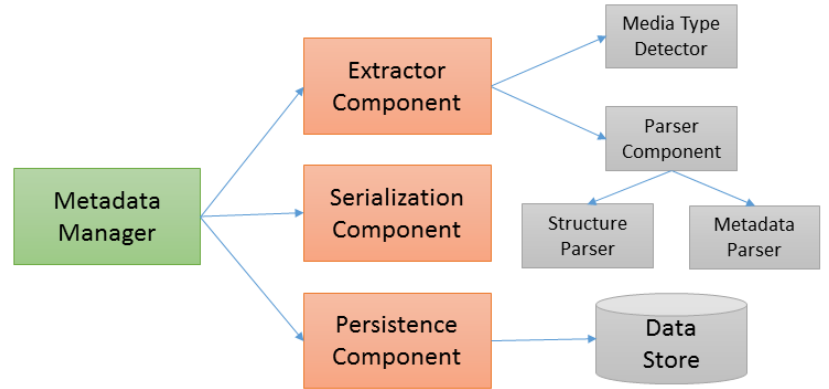
Figure 4. Overview of the system